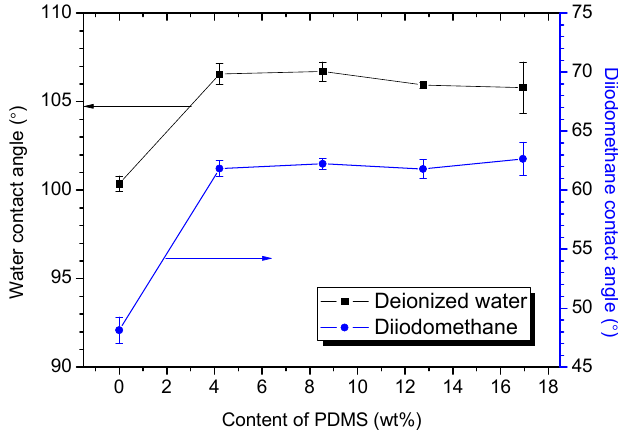
Figure 7. Water contact angle (WCA) and diiodomethane contact angle (DCA) measured results of the PU-Sis samples.